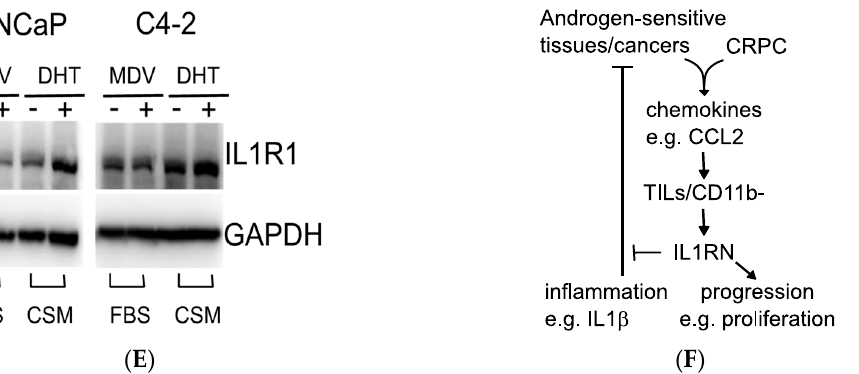
Figure 5. Proliferation effects of the interleukin (IL)-1 receptor antagonist (IL1RN) in human prostate cancer cell lines. ( A ) Monitoring of the proliferative effects of the IL1RN in several human prostate cell lines. Three prostate cancer cell lines (C4-2, DU145, and PC3) and one normal prostate epithelial cell line (RWPE-1) were treated with different concentration of the IL1RN for 3 days. ( B ) Monitoring of the antiproliferative effects of IL-1 β (IL1 β ). Cells (LNCaP and C4-2) were treated with different concentrations of IL1 β for different periods (3 d, 3 days; 4 d, 4 days). ( C ) Proliferation assay using the LNCaP cell line in combination of the IL1RN and IL1 β . Two sets of cells were treated with a dosage range of IL1RN (0~50 ng / mL) in combination with two fixed concentrations of IL1 β (0.1 and 0.5 ng / mL). ( D ) Androgen-induced recruitment of the androgen receptor (AR) to the genomic location of the IL-1 receptor, type 1 (IL1R1). Three sets of chromatin immunoprecipitation (ChIP) assays (LNCaP, LNCaP-SRC, and VCaP) in response to androgen (dihydrotestosterone (DHT) or R1881) were summarized using the UCSC Genome Browser. The GEO accession numbers are included in parentheses. The detected locations by ChIP were labeled with black bars; n / d, not detected. ( E ) IL1R1 protein levels in response to an AR inhibitor and agonist. Human prostate cancer cell lines (LNCaP and C4-2) were treated with MDV3100 (MDV) or DHT followed by a Western blot analysis. FBS, culture medium with 10% fetal bovine serum; CSM, medium with 10% charcoal-stripped serum. ( F ) A working model depicts the recruitment of cluster of differentiation 11b (CD11b)-deficient tumor-infiltrating leukocytes (TILs / CD11b − ) by tumor-associated proinflammatory chemokines (e.g., C-C motif chemokine ligand 2 (CCL2)). TILs / CD11b − cells secrete the IL1RN, which suppresses the antiproliferative effects of the inflammatory signals (e.g., IL1 β ) and promotes tumor progression (e.g., proliferation) of castration-resistant prostate cancer (CRPC). Student’s t -test. * p < 0.05, ** p < 0.01.